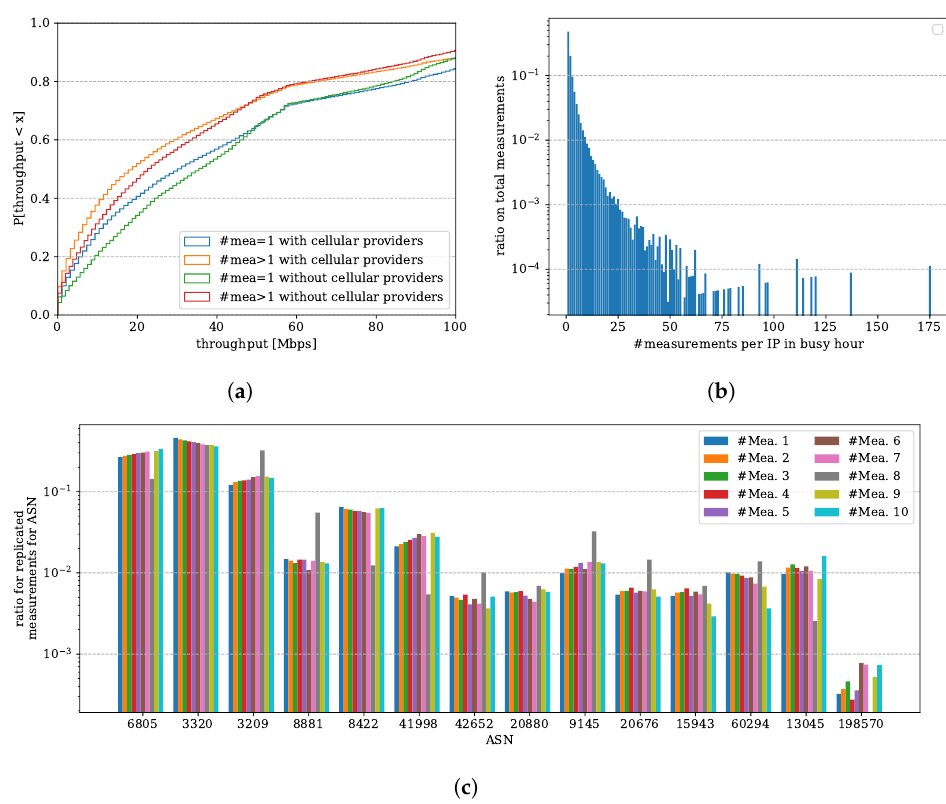
Figure 2. Impact of number of measurements performed by a single IP address during busy hours in August 2021 for TCP BBR: ( a ) CDF of the throughput for one or multiple measurements; ( b ) Ratio of IP addresses that perform X measurements; ( c ) Ratio of IP addresses that perform X measurements per